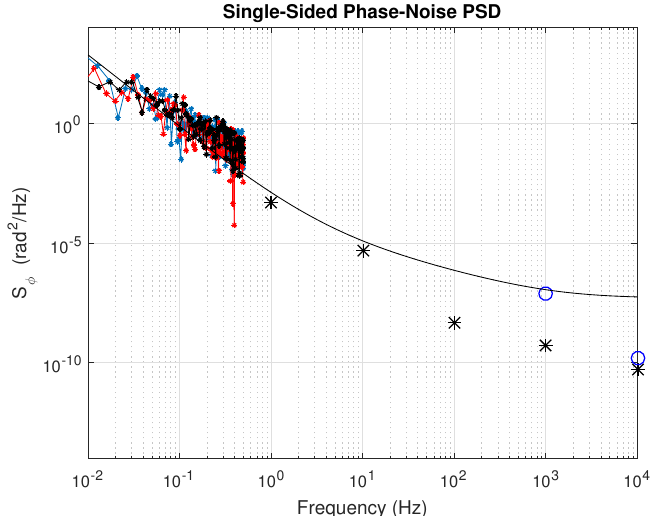
Figure A1. LPFRS measurements and specs with fitted power-law